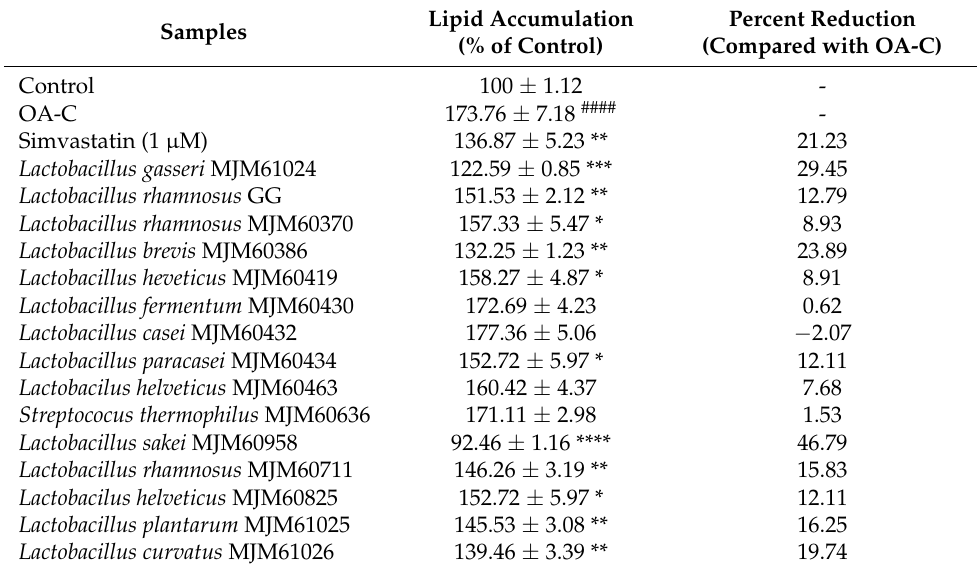
Table 1. Assessment of ability to inhibit lipid accumulation on HepG2 cells of candidate strains.